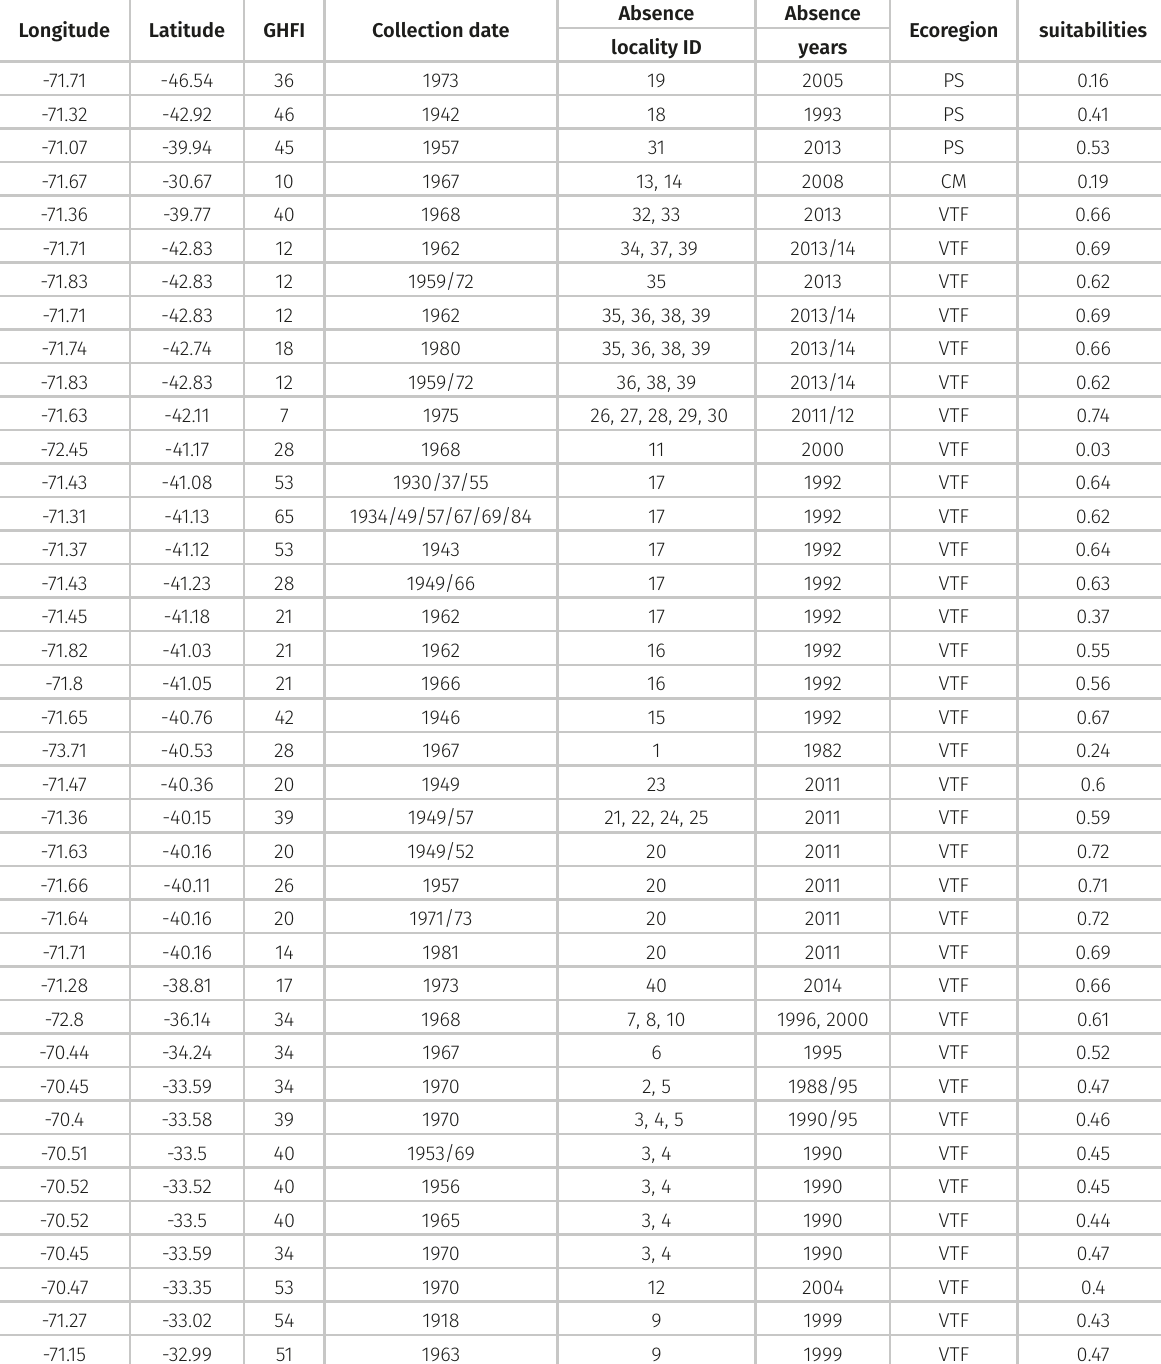
Table I. Localities where the species has been collected that are closer to 15 km to localities where N. chilensis could not be found (1987–2018). Information regarding locations, Global Human Footprint Index (GHFI), dates of collection, ID of the localities where it could not be found (further information in Supp. Mat 3) are provided. Abbreviations: Global Human Footprint Index: GHFI; VTF: Valdivian Temperate Forest; CM: Chilean Matorral; PS: Patagonian